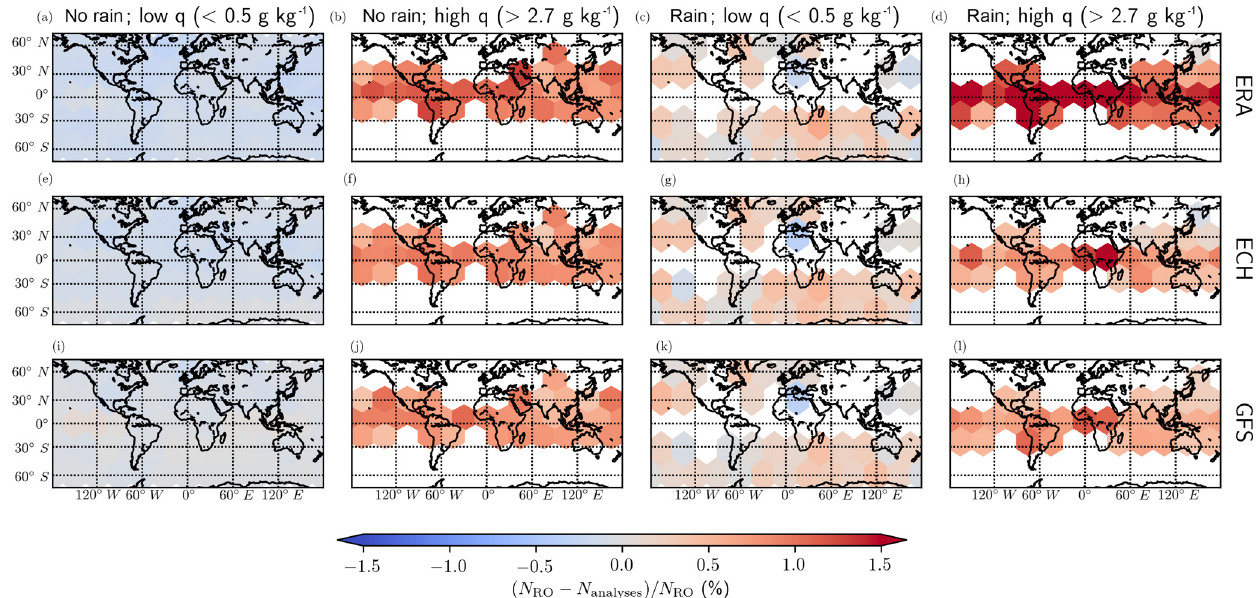
Figure 6. Regional averaged differences (color scale) between the observed and the analysis refractivity. Panels (a) – (d) correspond to ERA Interim, panels (e) – (h) correspond to ECMWF high-resolution, and panels (i) – (l) correspond to the GFS. Panels (a) , (e) , (i) , (b) , (f) , and (j) correspond to the free-of-rain data, where in (a) , (e) , and (i) the observed specific humidity at a height of 6.5km is lower than 0.5gkg − 1 and in (b) , (f) , and (j) is larger than 2.7gkg − 1 . Panels (c) , (g) , (k) , (d) , (h) , and (l) represent rain-affected data, where in (c) , (g) , and (k) the observed specific humidity at a height of 6.5km is lower than 0.5gkg − 1 and in (d) , (h) , and (l) is larger than 2.7gkg − 1 . The grid here corresponds to hexagons with a diameter of 30 ◦ . Only those with a minimum of 15 observations are